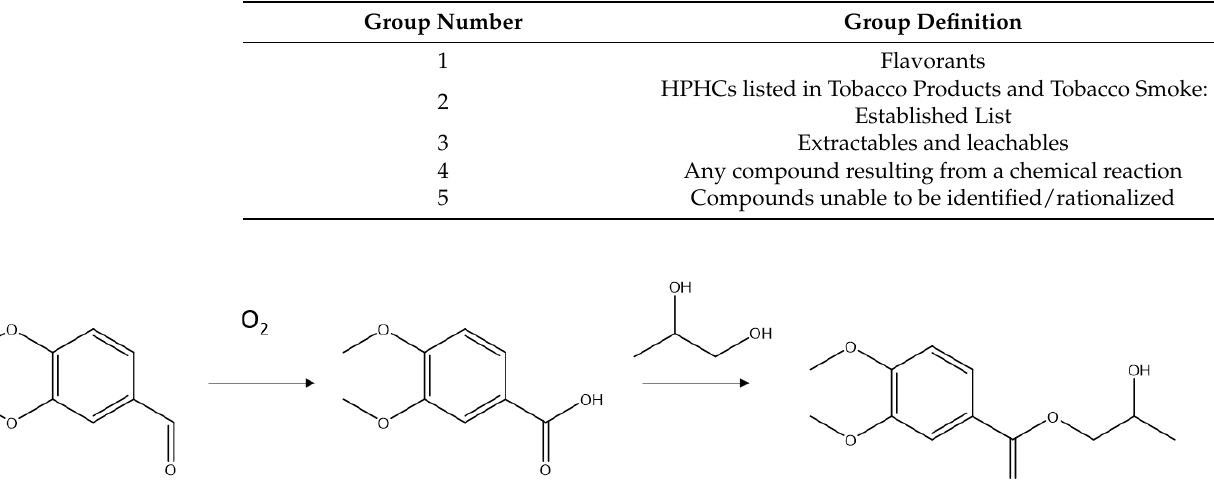
Table 1. Classification of Rational Compound Origin Identification.